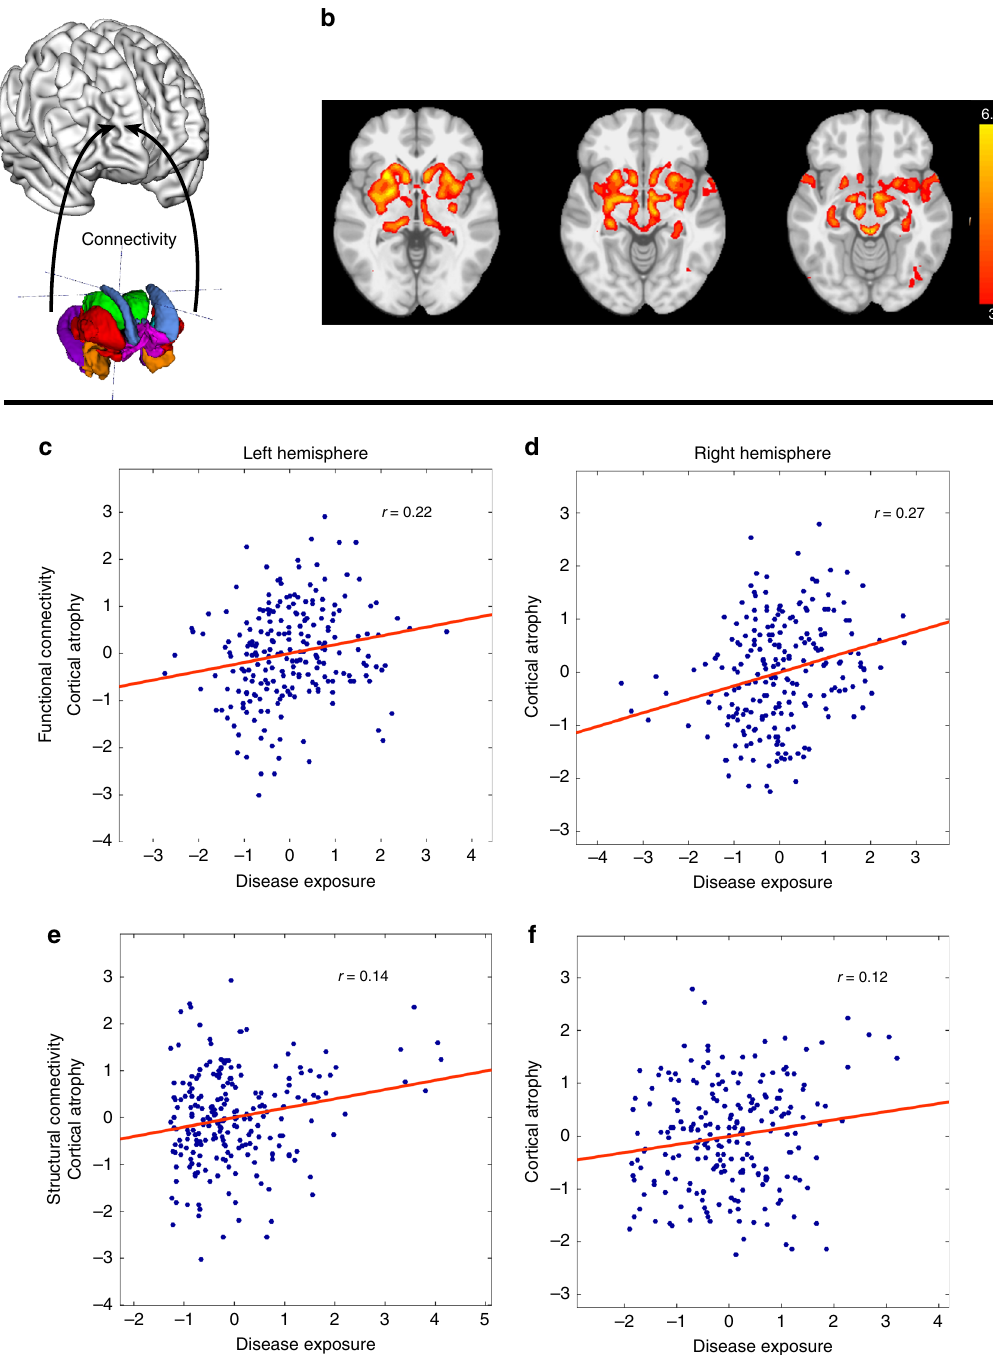
Fig. 4 Testing the propagation model. a Schematic of the propagation model. The model used a disease reservoir (colored regions) consisting of 15 subcortical regions of interest and connectivity from each region to the cortical surface. b PD-speci fi c atrophy map used to de fi ne disease “ content ” in each region of interest of the disease reservoir, derived from deformation-based morphometric analysis of patients at baseline (modi fi ed from Zeighami et al. 2015). c – e Correlation between cortical thinning (average t -values, PD – HC, t 2 – t 1 ) of each cortical region and disease exposure (see text for detail). Connectivity based on functional resting state data in the c left and d right hemisphere as well as connectivity based on diffusion-weighted data in the e left and f right hemisphere are